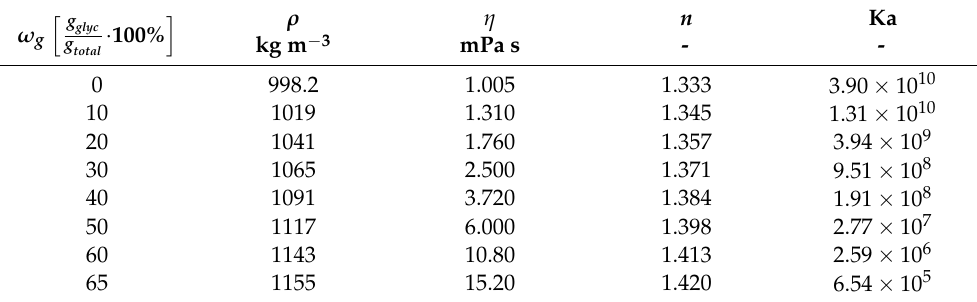
Table 1. Physical properties of water and glycerol-water mixture at 20 ◦ C